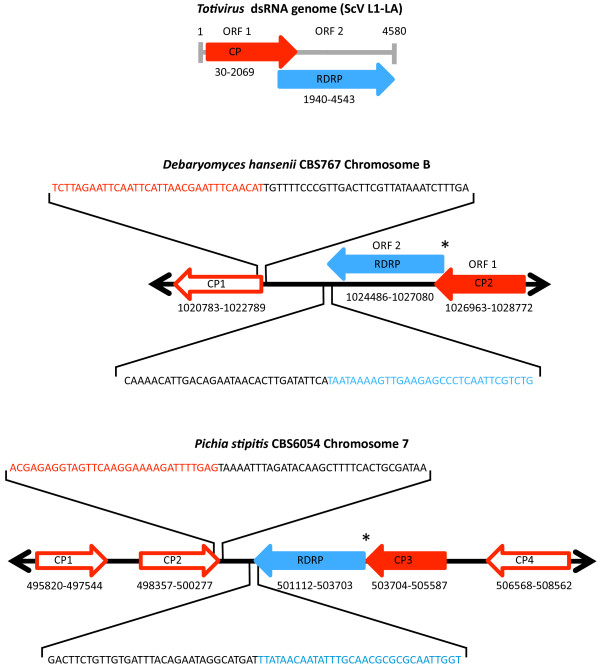
A comparison of the simple genome of Totivirus, a dsRNA virus, with the fungal genome maps containing proposed endogenous Totivirus-like genes and open reading frames. Red arrows indicate capsid polypeptide-like genes and the blue arrows represent RNA-dependent RNA polymerase-like genes. These coloured arrows represent open reading frames). Gray lines represent an RNA based genome and black lines represent fungal chromosomal DNA. Gene copies that retain an exogenous viral genomic architecture are shown as solid coloured arrows with the coding strand indicated by the direction of the arrow. Sequences from the present study that reveal fungal-Totivirus-like genes boundaries are shown above the maps. Asterisks represent further gene boundary regions amplified successfully by polymerase chain reaction (PCR; see Figure 6A). Numbers below the gene annotations indicate the chromosomal positions of gene boundaries. Full sequences of the PCR products from these regions have the Genbank Accession numbers: GQ291318-GQ291321.